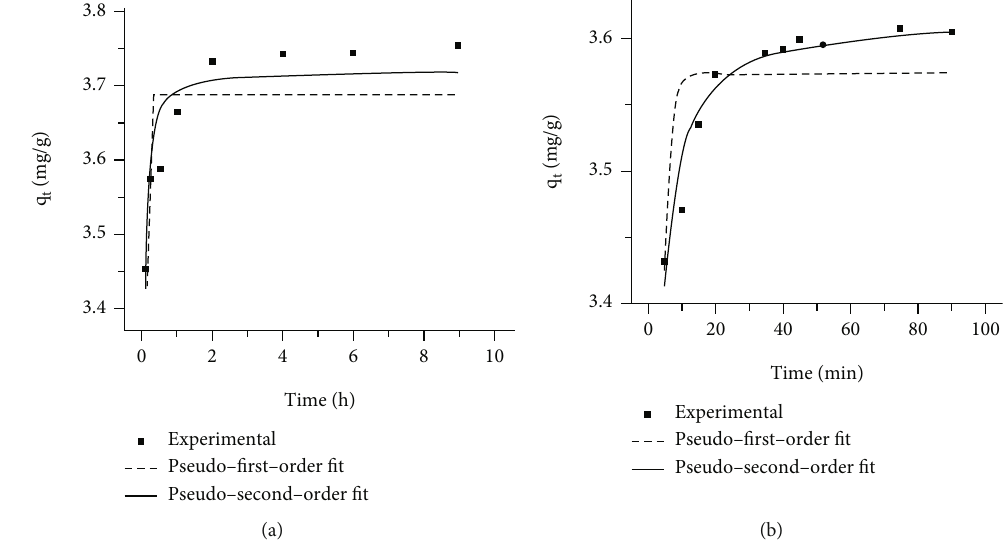
Figure 5: The kinetic models represented by PFO and PSO for (a) BB and (b) EVML. Table 2: PFO and PSO model parameters for MB adsorption onto BB and EVML.